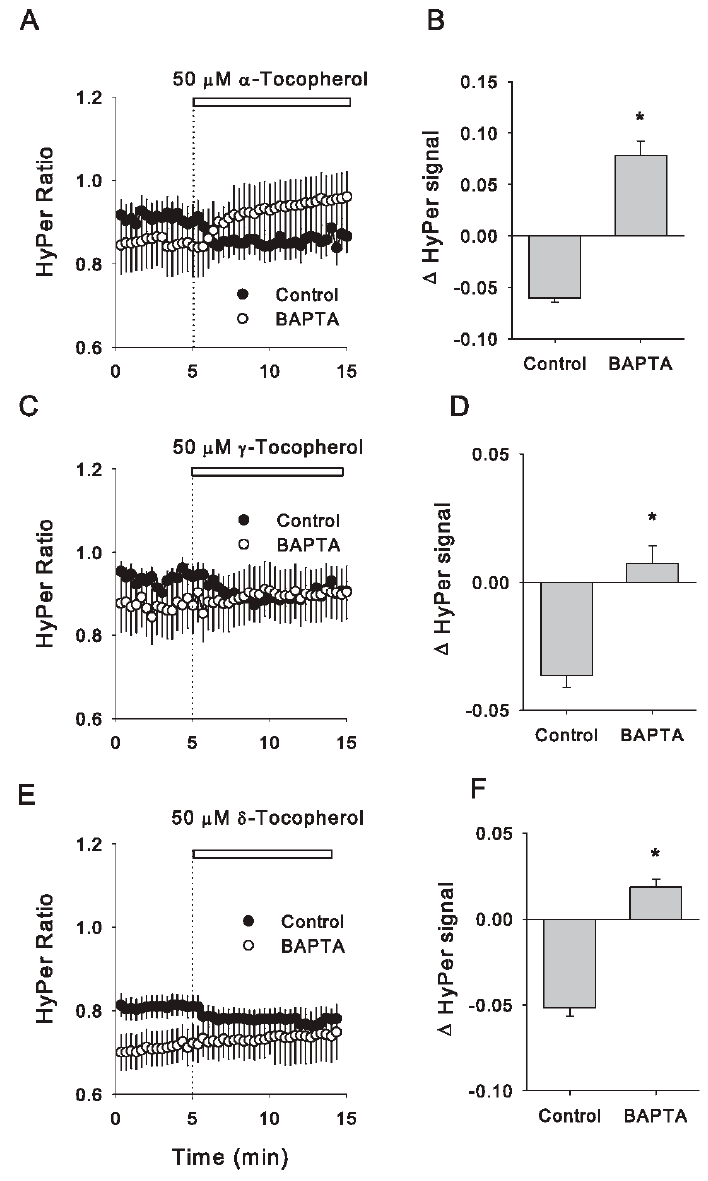
Figure 6. Intracellular calcium chelation abolishes a redox effect of tocopherol isomers on HyPer-expressing Caco-2 cells. Time courses of HyPer signal showing the effect of the three tocopherol isomers (50 μ M) in nontreated cells (filled circles) and cells treated with 75 μ M BAPTA (open circles). Isomer addition is shown by a dotted line and a white bar on each plot. ( A ), α -tocopherol was applied in 34 control cells from four experiments and 12 cells treated with BAPTA from three experiments. ( B ), changes in HyPer ratio induced by α -tocopherol exposure expressed as the difference between the signals obtained after 3 min of tocopherol addition and its respective baselines; this analysis was done for control and BAPTA-treated cells. As for ( A , B ), ( C ) shows the effect of adding of γ -tocopherol, whereas data analysis is depicted in ( D ). Data correspond to the average ± SE from 44 control cells from four experiments and 16 BAPTA-treated cells from three independent experiments. ( E ) The effect of δ -tocopherol is shown in 24 control cells from four experiments and 12 BAPTA-treated cells from three independent experiments. Data are expressed as the average ± SE. Data analysis is shown in ( F ). Asterisks (*) mean significant differences between control and BAPTA-treated groups (nonpaired t-Student test).